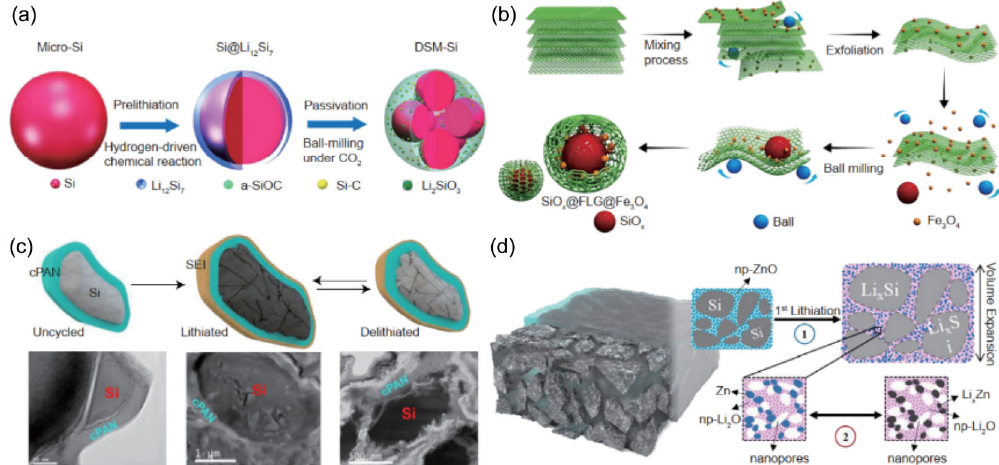
Figure 7 (a) Schematic illustration of the DSM-Si fabrication procedure. Reproduced with permission from Ref. [133], © Elsevier B.V. 2018. (b) Schematic diagram of the two-step ball-milling method for FLG (few-layered graphene)-wrapped and Fe 3 O 4 -pillared SiO x composites. Reproduced with permission from Ref. [134], © Elsevier B.V. 2018. (c) Self-contained fragmentation mechanism in which cPAN coatings mechanically confine the fractured μSi particles. Reproduced with permission from Ref. [139], © IOP Publishing 2018. (d) Binder-less, additive-less np-ZnO/SiMP electrode structure and the two-step lithiation mechanism involving the conversion reaction of the np-ZnO and alloying reaction SiMPs that enable extended stable electrochemical cycling. Reproduced with permission from Ref. [140], © American Chemical Society